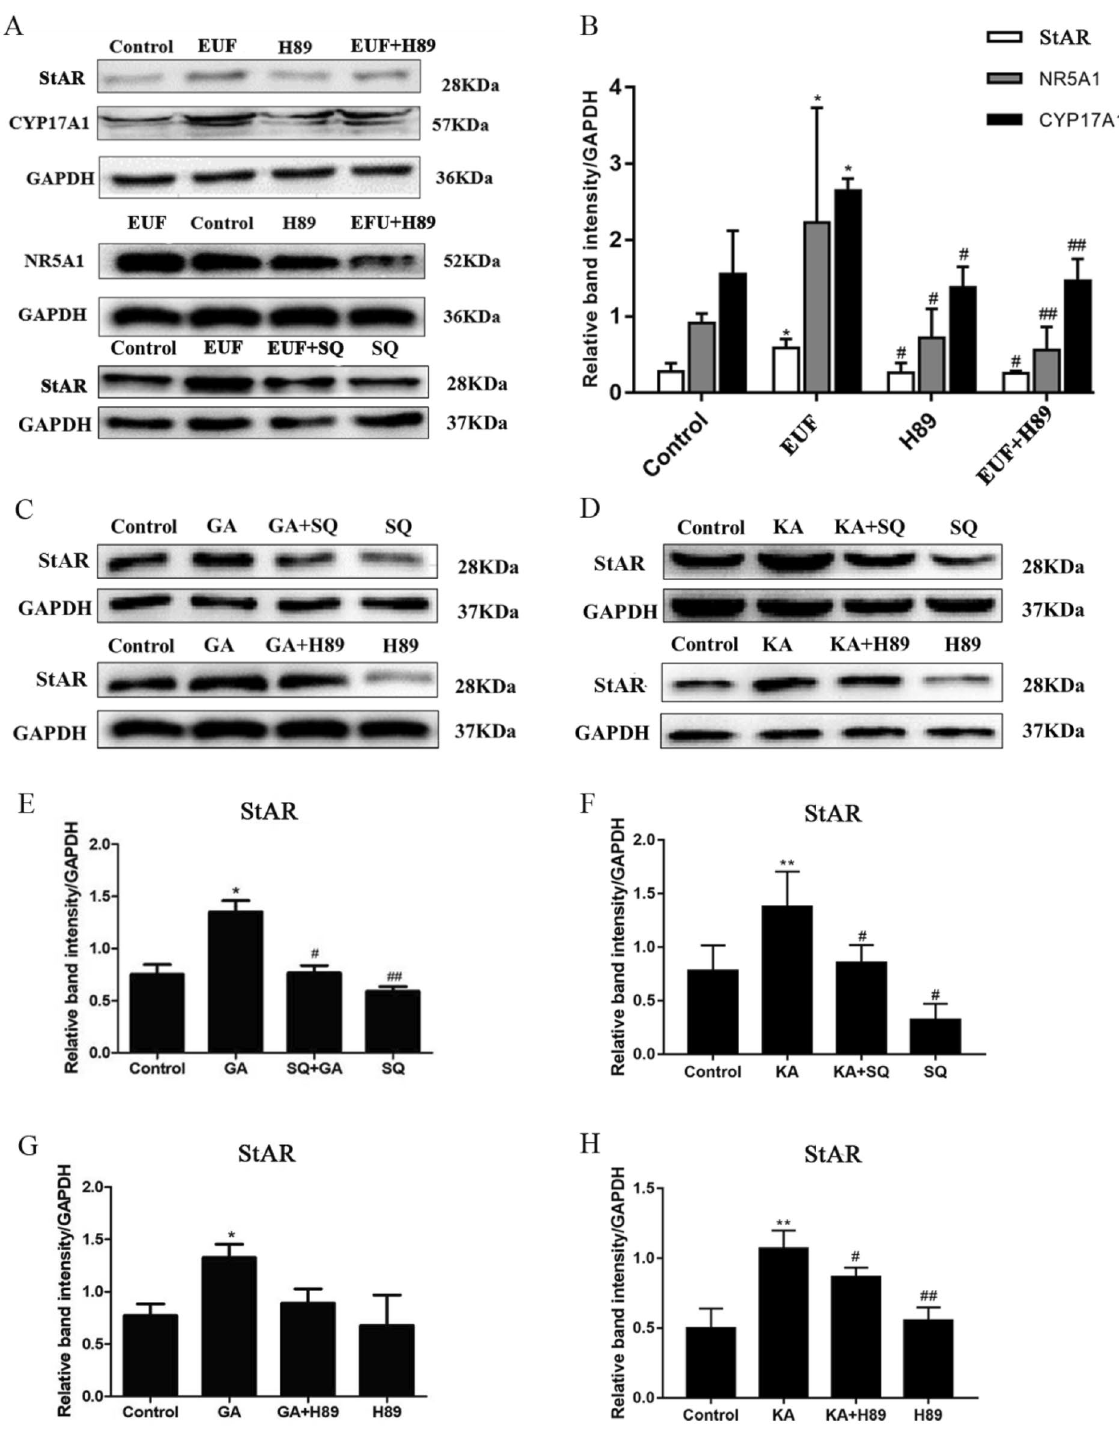
Figure 4. Effects of EUF extract ( A , B ), kaempferol, and geniposidic acid ( C – H ) on protein expression of the steroidogenic pathway in Leydig cells under the treatment of inhibitors. * P < 0.05, ** P < 0.01 versus the control group. # P < 0.05, ## P < 0.01 versus the EUF, GA, or KA group. KA, kaempferol; GA, geniposidic